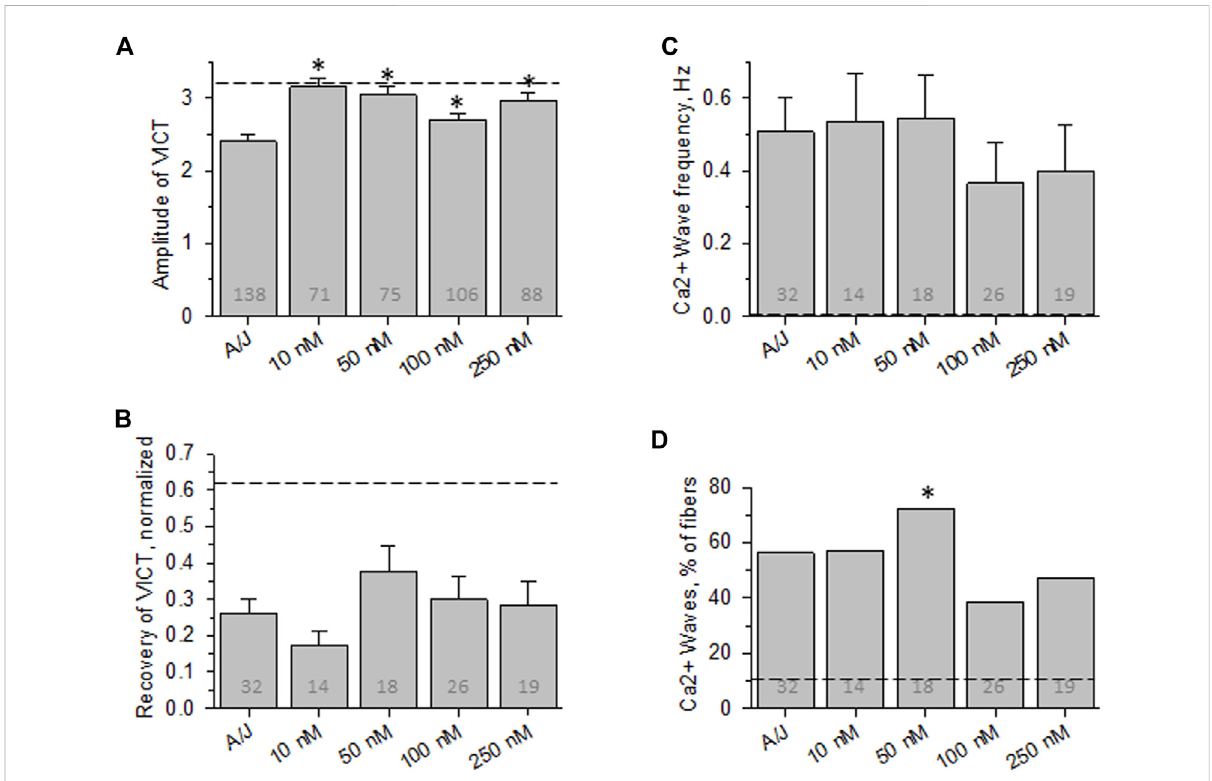
FIGURE 4 Effect of osmotic shock injury on Ca 2+ transientsin A/J FDB fi bers preloaded with differentconcentrations of EGTA-AM. As in Figure 2, but with myo fi bers loaded with EGTA-AM. (A) , averaged amplitudes of Ca 2+ release before OSI presented as (F max -F 0 )/F 0 . (B) , averaged data for recovery of Ca 2+ transients at 5 min after OSI. (C) , averaged data for frequency of Ca 2+ waves at 5 min after OSI. (D) , % fi bers that produced Ca 2+ waves at 5 min after OSI. Dashed lines represent values obtained with A/JCr fi bers. *, p < 0.05 compared to A/J. N is indicated in each bar. Student ’ s t test was used for (A – C) ; Χ 2 was used for